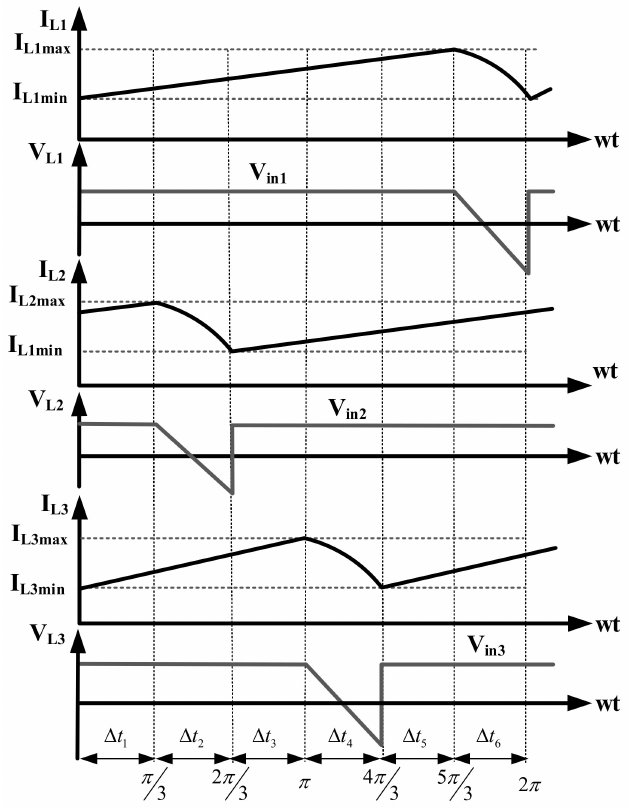
Figure 3. Ideal waveforms of three-input step-up